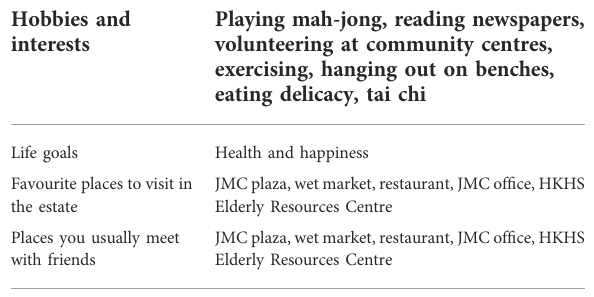
TABLE 2 Resident ’ s daily routines.